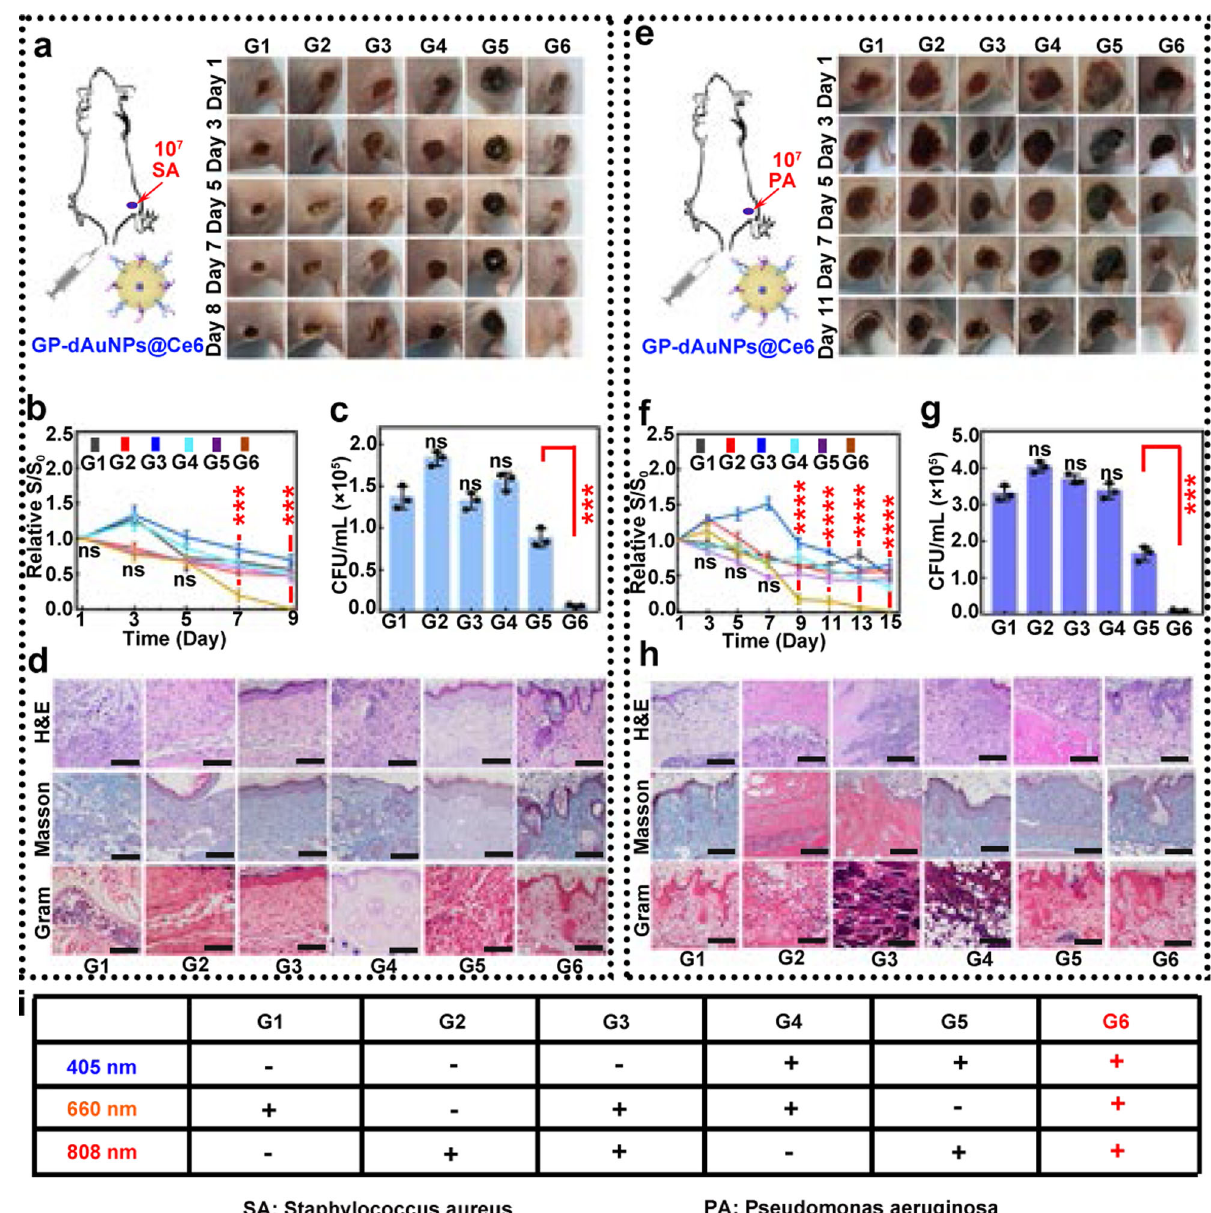
Fig. 7 Aggregation-enhanced in vivo antibacterial activity based on the developed strategy. a Representative photographs of SA-infected mice injected with GP-dAuNPs@Ce6 with different irradiations of 405, 660, and 808 nm laser. b Corresponding time-dependent relative wound area (S/S 0 ) SA-infected mice. c Bacterial counts (CFU mL − 1 ) excised from the SA-infected tissues of mice at 8-day post-injection. d Corresponding histological images of SA- infected skin tissues of mice at 8-day post-injection. Scale bars, 50 μ m. e Representative photographs of PA-infected mice injected with GP-dAuNPs@Ce6 with different treatments of 405, 660, and 808 nm laser irradiation. f Corresponding time-dependent relative wound area (S/S 0 ) PA-infected mice after different treatments. g Bacterial counts (CFU mL − 1 ) excised from the PA-infected tissues of mice at 11-day post-injection. h Corresponding histological images of PA-infected skin tissues of mice at the 11-day post-injection. Scale bars, 50 μ m. i Division of the mice into six therapy groups. The mice in group 1 (G1) are treated with GP-dAuNPs@Ce6 + 660-nm laser (12 mWcm − 2 , 5 min); The mice in group 2 (G2) are treated with GP-dAuNPs@Ce6 + 808-nm laser (1.0 W cm − 2 , 5 min); the mice in group 3 (G3) are treated by GP-dAuNPs@Ce6 + 660-nm laser (12 mWcm − 2 , 5 min) + 808-nm laser (1.0 W cm − 2 , 5 min); the mice in group 4 (G4) are treated by GP-dAuNPs@Ce6 + 405-nm laser (1.0 W cm − 2 , 25 min) + 660-nm laser (12 mW cm − 2 , 5 min); the mice in group 5 (G5) are treated by GPdAuNPs@Ce6 + 405-nm laser (1.0 W cm − 2 , 25 min) + 808-nm laser (1.0 W cm − 2 , 5 min); the mice in group 6 (G6) are treated by the GP-dAuNPs@Ce6 + 405-nm laser (1.0 W cm − 2 , 25 min) + 660-nm laser (12 mW cm − 2 , 5 min) + 808-nm laser (1.0 W cm − 2 , 5 min). All imaging experiments were repeated three times with similar results. Statistical analysis was performed using a one-way ANOVA analysis. Error bars represent the standard deviation obtained from three independent measurements. Data are presented as mean values ± SD (*** means p < 0.001, **** means p < 0.0001, n = 3). Source data are provided as a Source Data fi le.